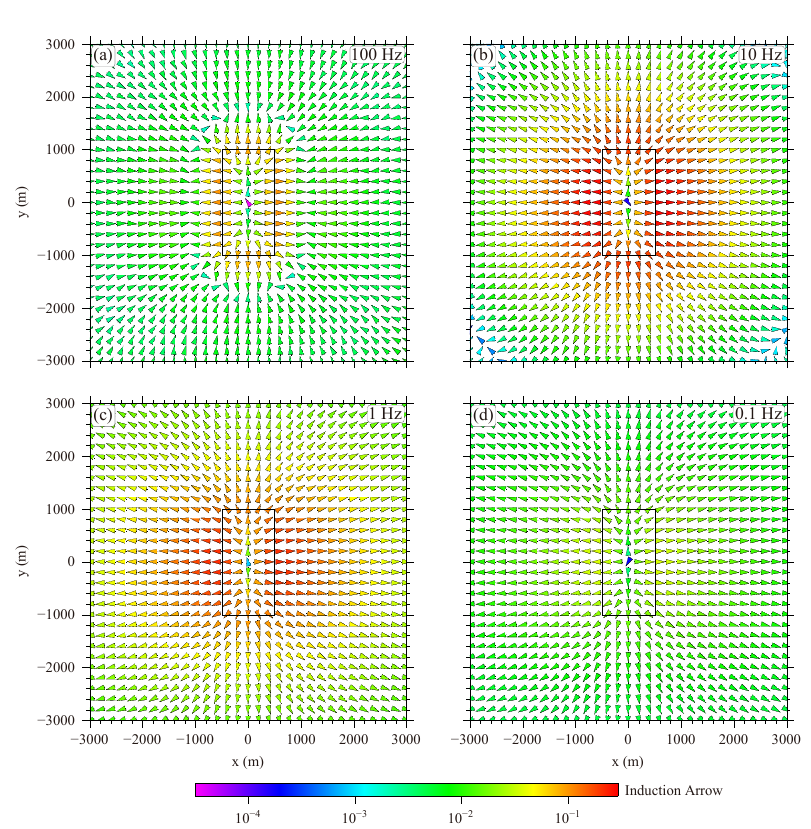
Figure 4. The induction arrow for the COMMEMI 3D-1A model. ( a – d ) are for the frequencies of 100, 10, 1, and 0.1 Hz, respectively. The black rectangles indicate the projection of the conductive blocks on the x - y plane. Table 1. The apparent resistivities calculated by the FE method for the COMMEMI 3D-1A model. The frequency was set to 0.1 Hz. The apparent resistivity unit is Ω m.